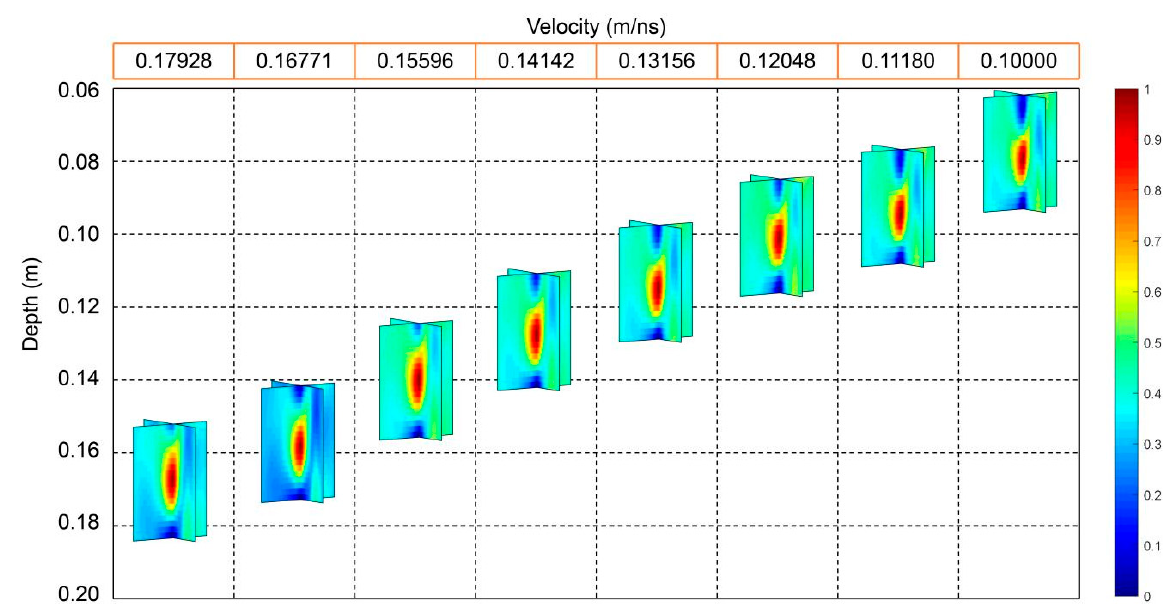
Figure 3. Vertical slices of migrated GPR data with different velocities.